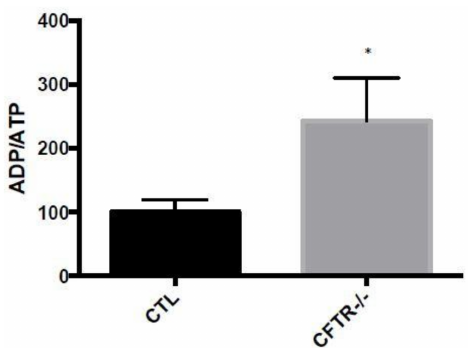
Figure 5. Effects of CFTR deletion on mitochondrial ADP/ATP ratio. Caco-2/15 cells were allowed to differentiate until 15 days after confluence. Then, cells were, harvested, trypsinized and homogenized. The ADP/ATP ratio was measured in isolated mitochondria by a bioluminescence assay. Values are means ± SEM of 3 independent experiments, each performed in triplicate. * p < 0.05 vs. CTR cells. CTR: control cells; FA: iron/ascorbate (200 µ M/0.5 mM); BHT: Butylated hydroxy toluene (0.5